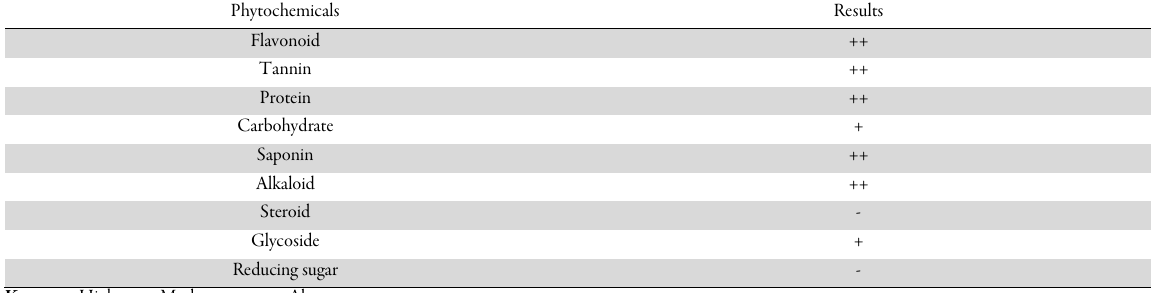
Table 1. Phytochemicals evaluation of the ethanolic stem bark extract of C. albidum